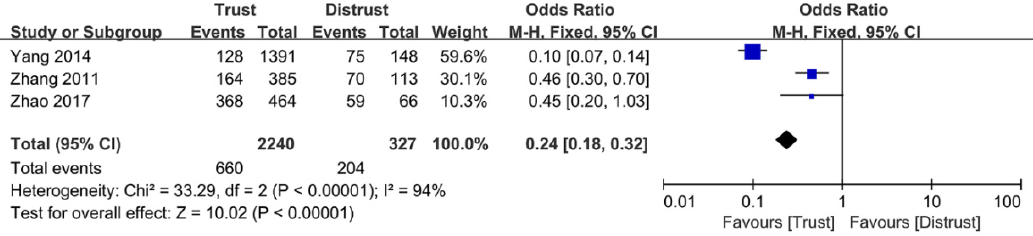
Figure 4. The forest plot of healthcare worker-patient trust.